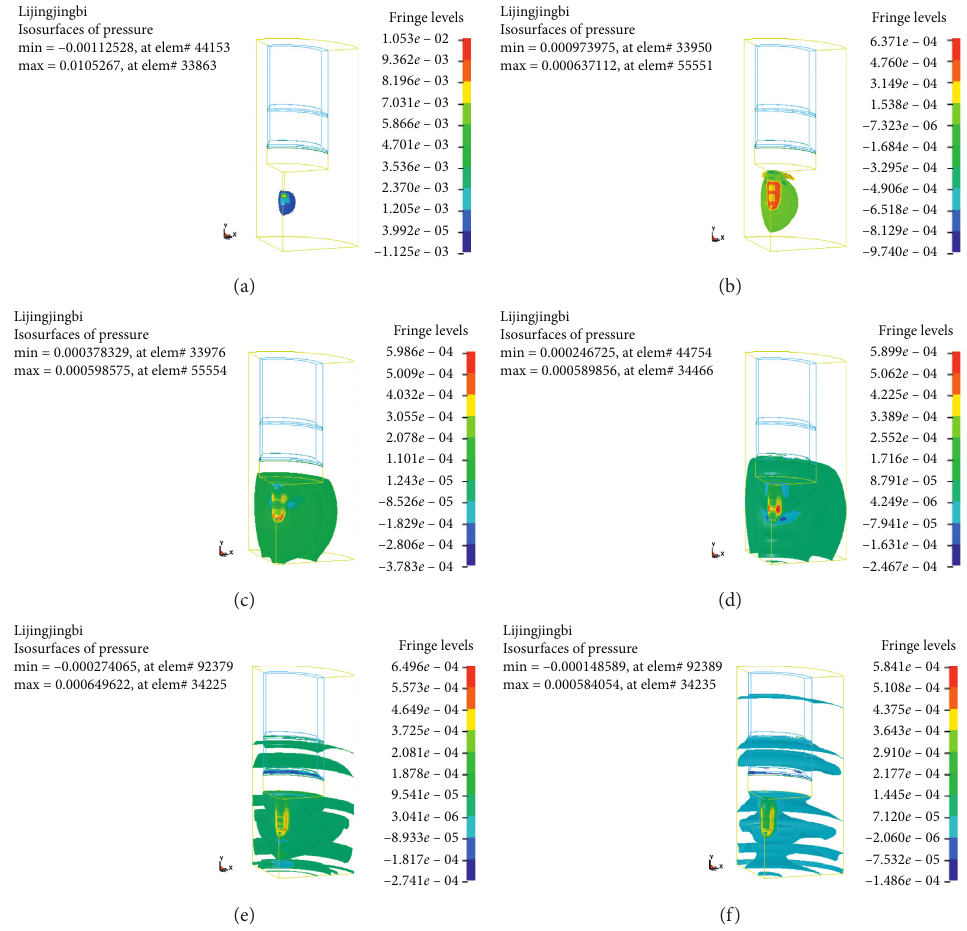
Figure 4: Spread process of stress waves. (a) t � 300 us, (b) t � 1100us, (c) t � 1700us, (d) t � 2000us, (e) t � 3000us, and (f) t �